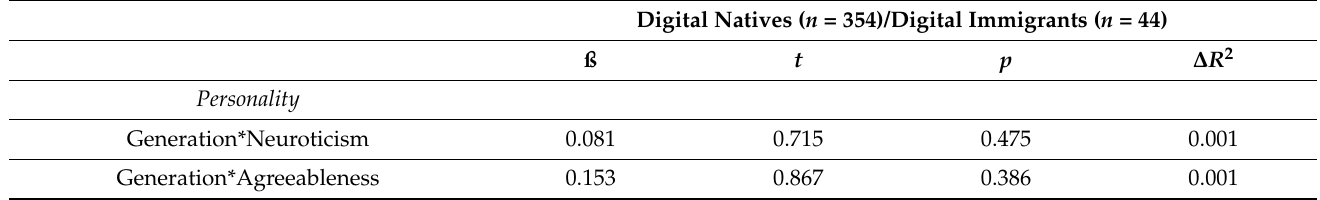
Table 4. Moderation for digital natives and digital